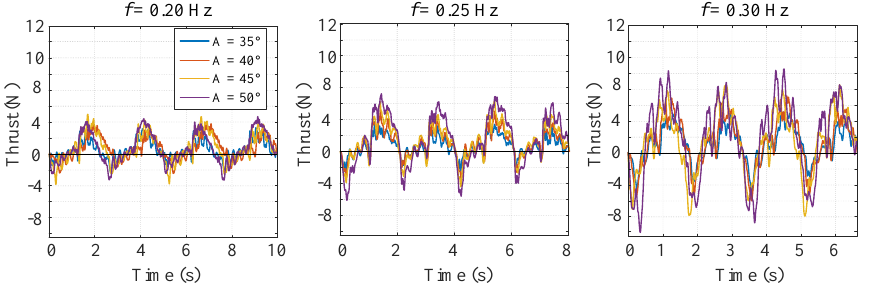
Figure 6. Experimental results of instant mode.